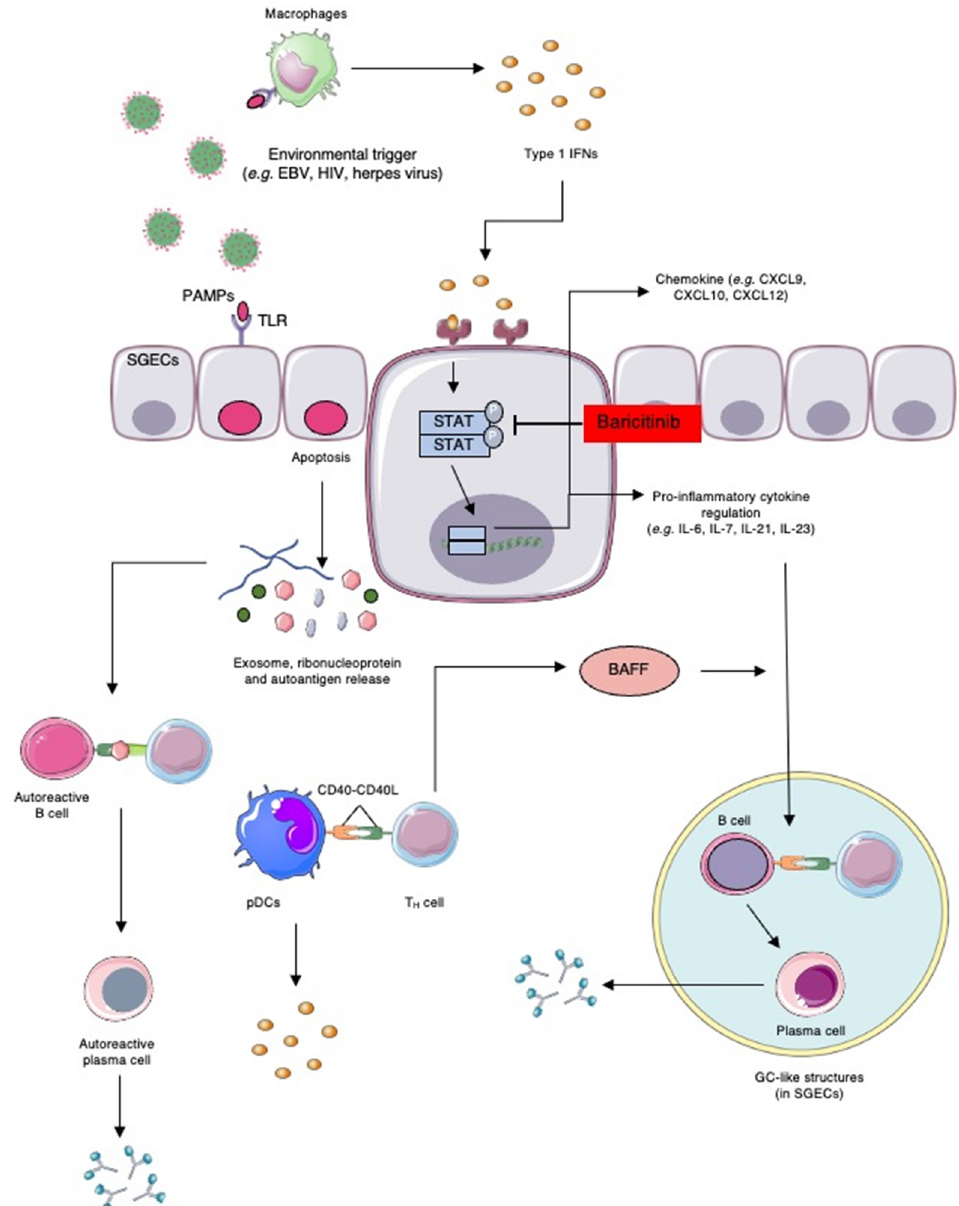
Figure 2. Schematic representation of Sjogren’s syndrome pathogenesis. Environmental triggers, such as viruses, are known to activate innate immunity cells (e.g., macrophages) through pathogen- associated molecular patterns (PAMPs) and pathogen recognition receptors (i.e., toll-like receptors (TLRs)). The activation of TLRs induces a pro-inflammatory microenvironment, marked by the production of type 1 interferons (IFNs). IFNs enhance pro-inflammatory cytokine production by activating the JAK-STAT pathway in salivary gland epithelial cells (SGECs). Ultimately, the pro- inflammating environment leads to the formation of germinal center (GC)-like structures, composed of a tremendous number of activated B and T cells. (The Figure was partly generated using Servier Med- ical Art, provided by Servier, licensed under a Creative Commons Attribution 3.0 unported license). Three types of IFNs exist: type I, type II, or type III. Type 1 IFNs are polypeptides that generally serve to limit pathogenic spread, modulate innate immunity, restrain pro- inflammatory pathways, and promote adaptive immunity. The IFN α subtypes and IFN β remain the most studied type 1 IFNs in rheumatic diseases [34]. In SS, the principal actors involved in IFN α production are plasmacytoid DCs (pDCs). It was shown that